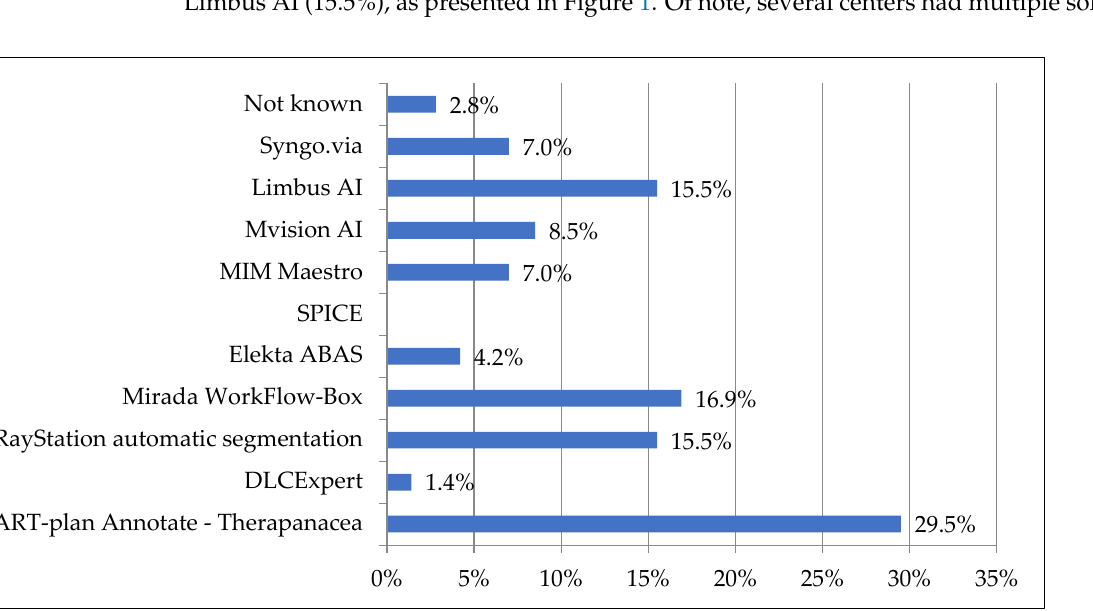
Figure 1. Distribution of automatic segmentation solutions in France, on a participant ‐ by ‐ participant analysis.